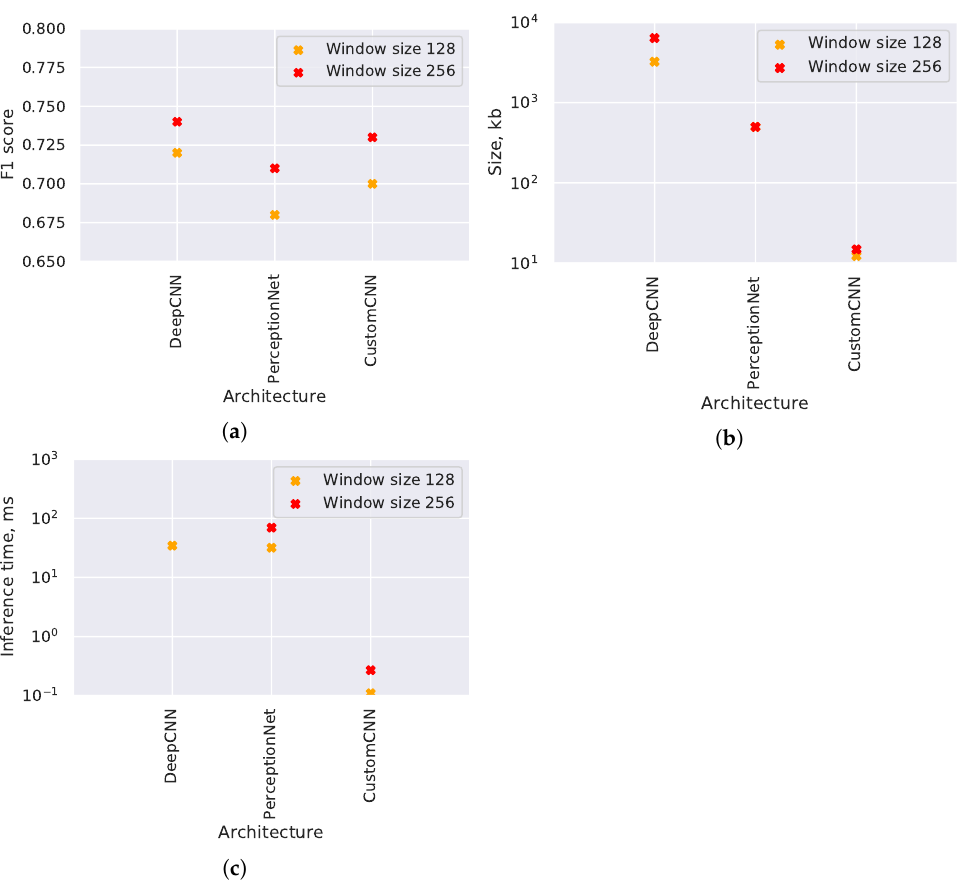
Figure 5. CNN accuracy and performance depending on the architecture. Results on Raspberry Pi; DeepCNN with window size 256 fails to fully build on this system; its inference speed is not measured. ( a ) F 1 scores. ( b ) Memory usage. ( c ) Inference